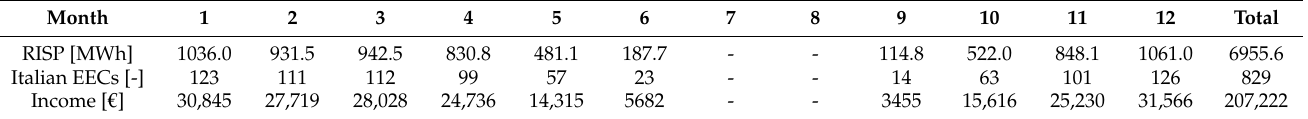
Table 8. EEC results of the thermal power plant (year